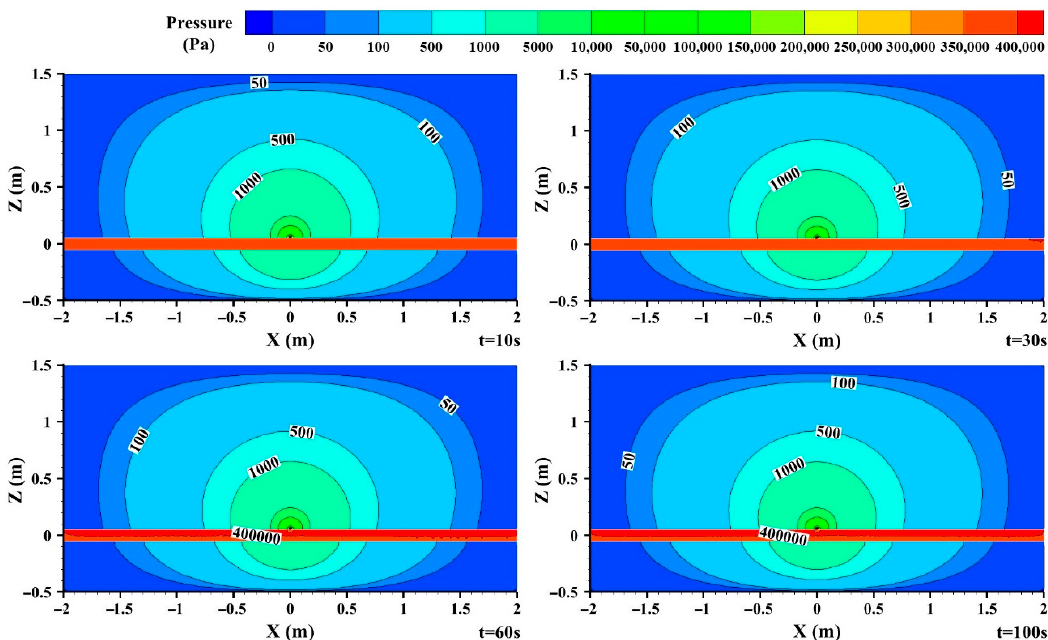
Figure 5. Cloud diagram of pressure distribution at different leakage times.